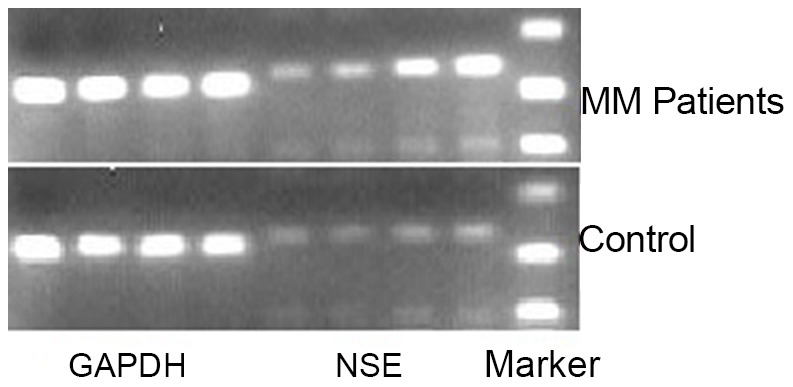
RT-PCR product electrophoresis for GAPDH (control and NSE) in previously untreated MM patients and controls.